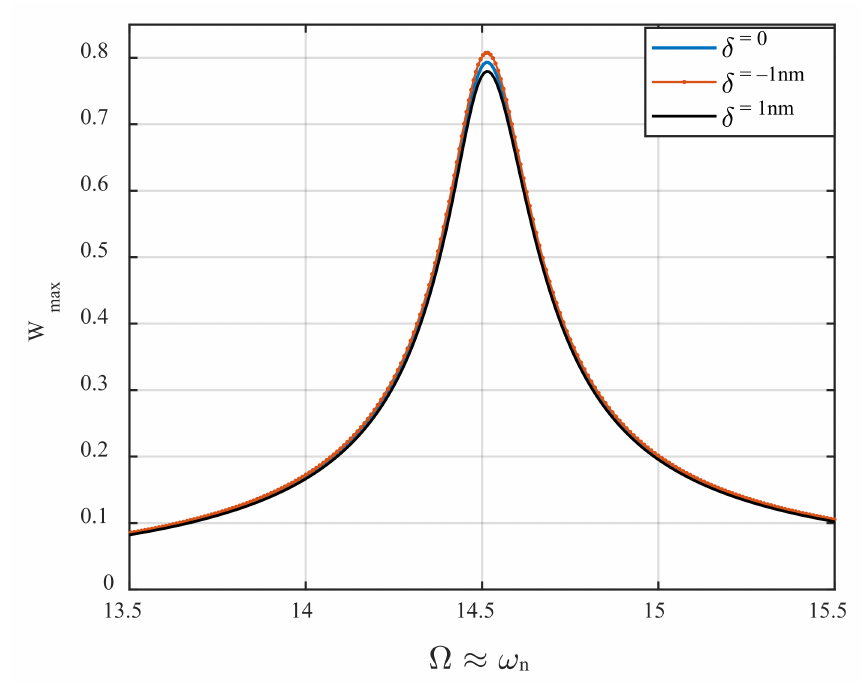
Figure 7. The influence of the surface profile variations on the resonance amplitude of the microcan- tilever near primary resonance, for d 0 = 0.15